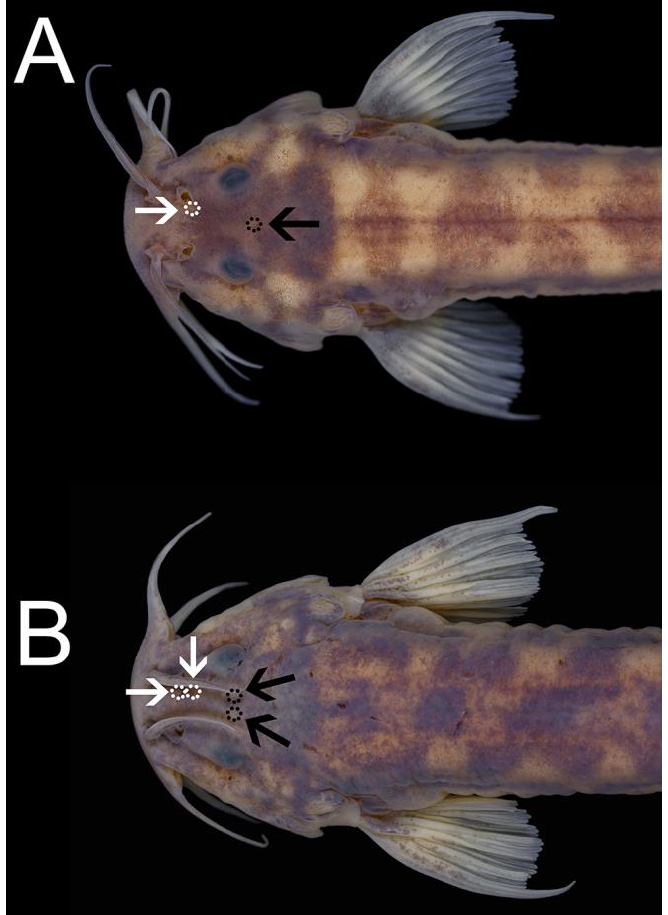
Figure 9. Head, dorsal view: ( A ) Trichomycterus goeldii , UFRJ 7938, 57.9 mm SL; ( B ) Trichomycterus auroguttatus , UFRJ 11675, 59.2 mm SL. Black arrows, S6 pores; white arrows, S3 pores.